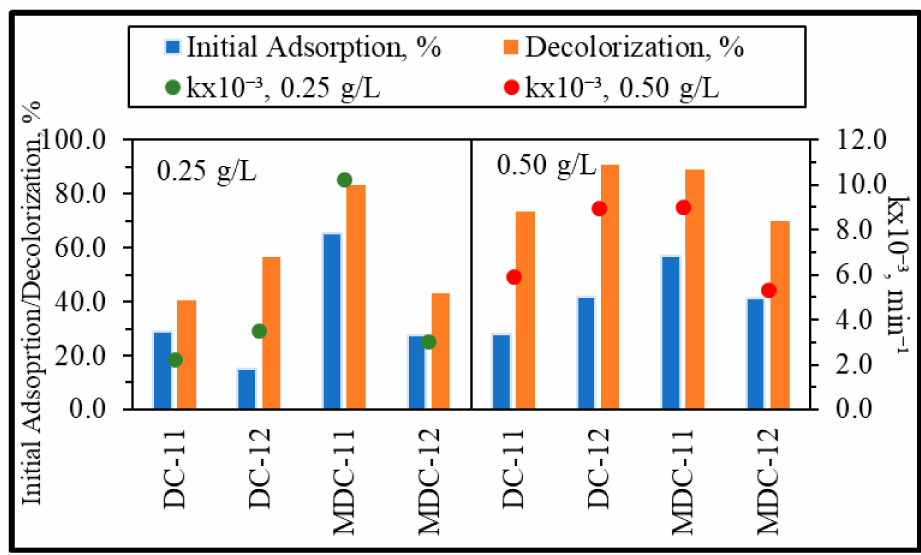
Figure 9. Comparison of dose-dependent initial adsorption extents and decolorization efficiencies MB, A 664 with respect to first-order kinetic rate